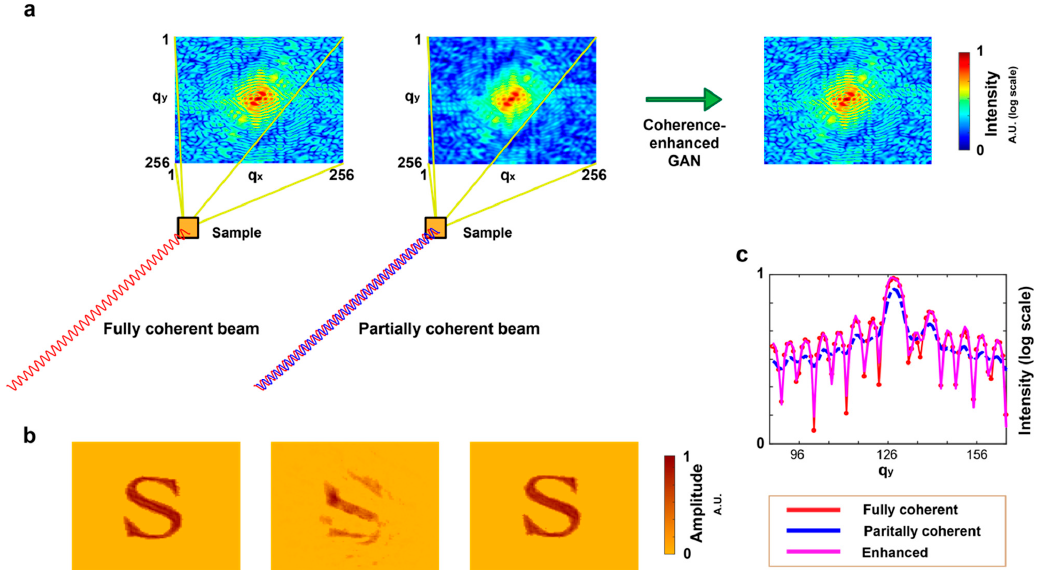
Figure 4. The performance of coherence-enhanced GAN in transmission coherent diffractive imaging. ( a ) Fully coherent, partially coherent, and coherence-enhanced diffractive images (from left to right). ( b ) The reconstructed images from fully coherent (left), partially coherent (middle), and coherence-enhanced diffractive images (right). The original image size is 256 × 256, but the images in ( b ) are 128 × 128 crops around the object. ( c ) Line-outs through the center of the diffraction patterns.